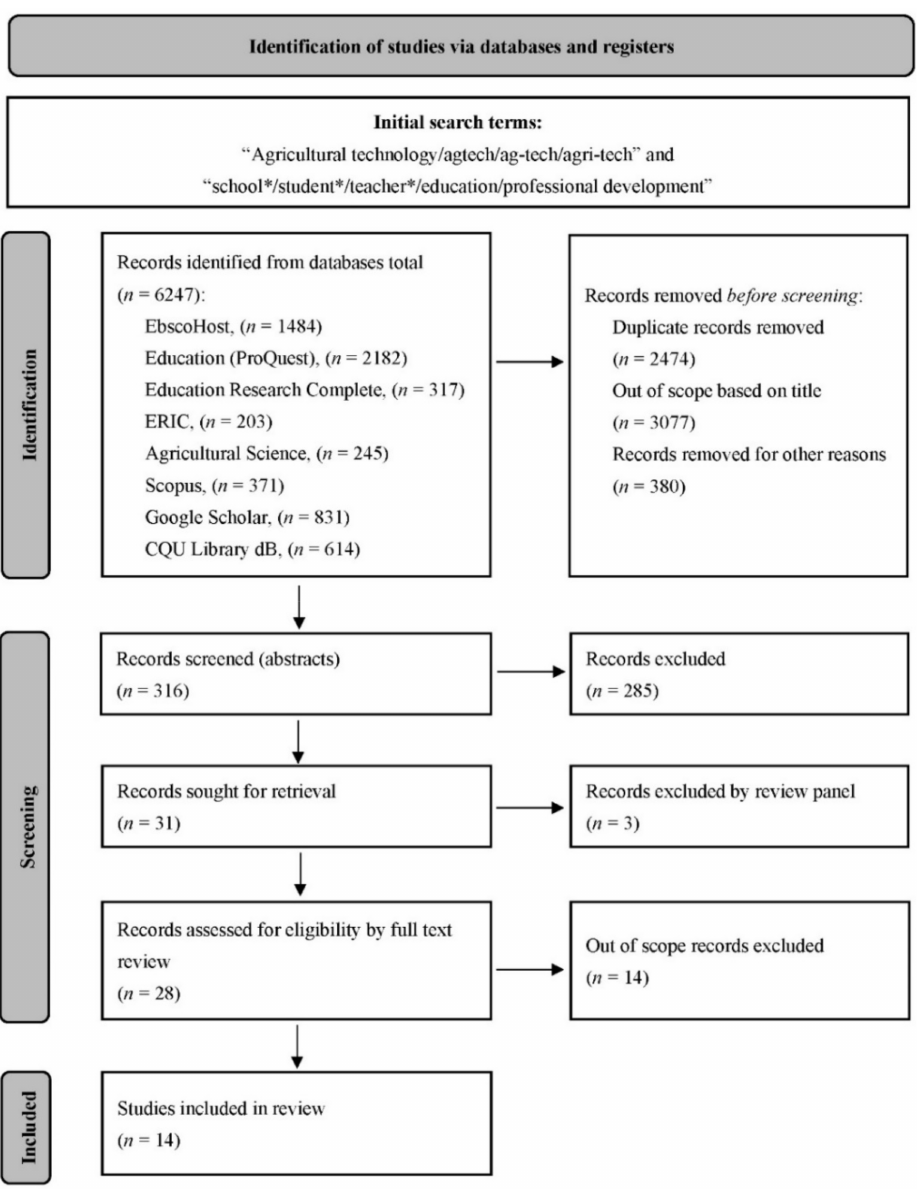
Figure 1. PRISMA Flow Diagram (Adapted from Page et al. 2021). * indicates search terms with multiple